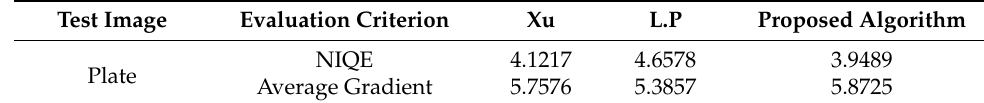
Table 7. Final results of the IQA.